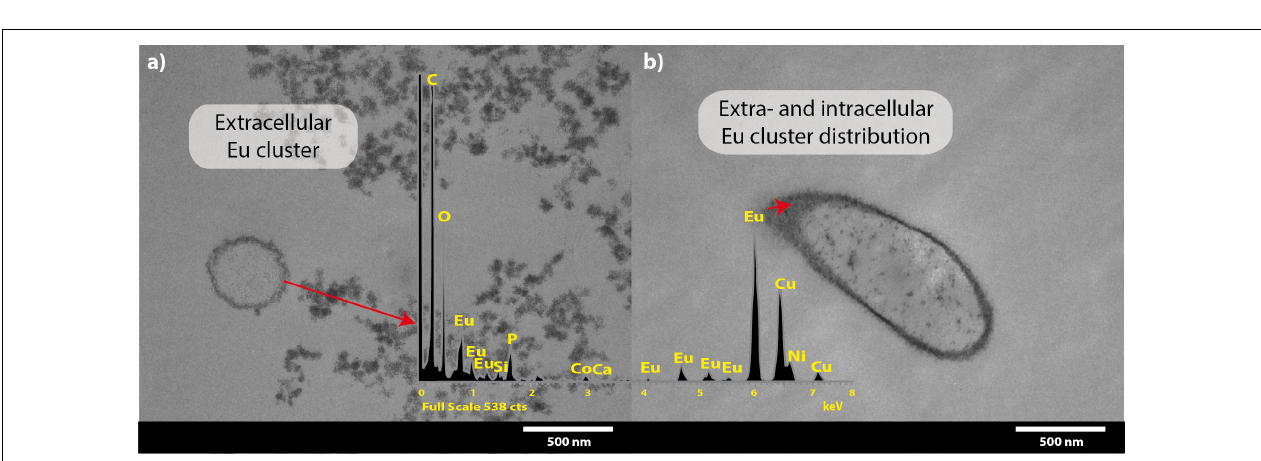
FIGURE 3 | Scanning electron microscopy micrographs of T. scotoductus SA-01. Bars indicate the scale as micrometers and red arrows indicate EDX spectra. Control (a) and Eu amended cells (b) .